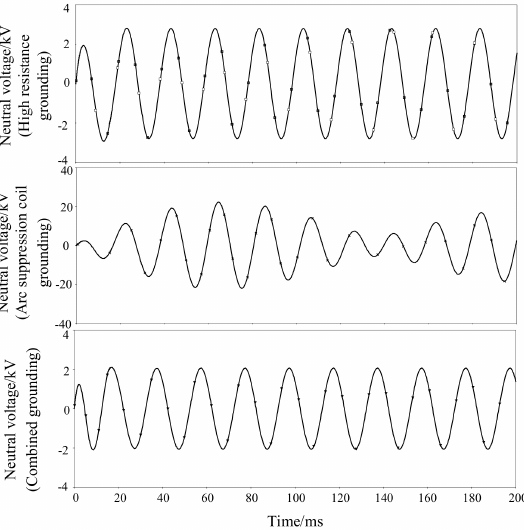
Figure 8. Transition resistance grounding neutral voltage drift.